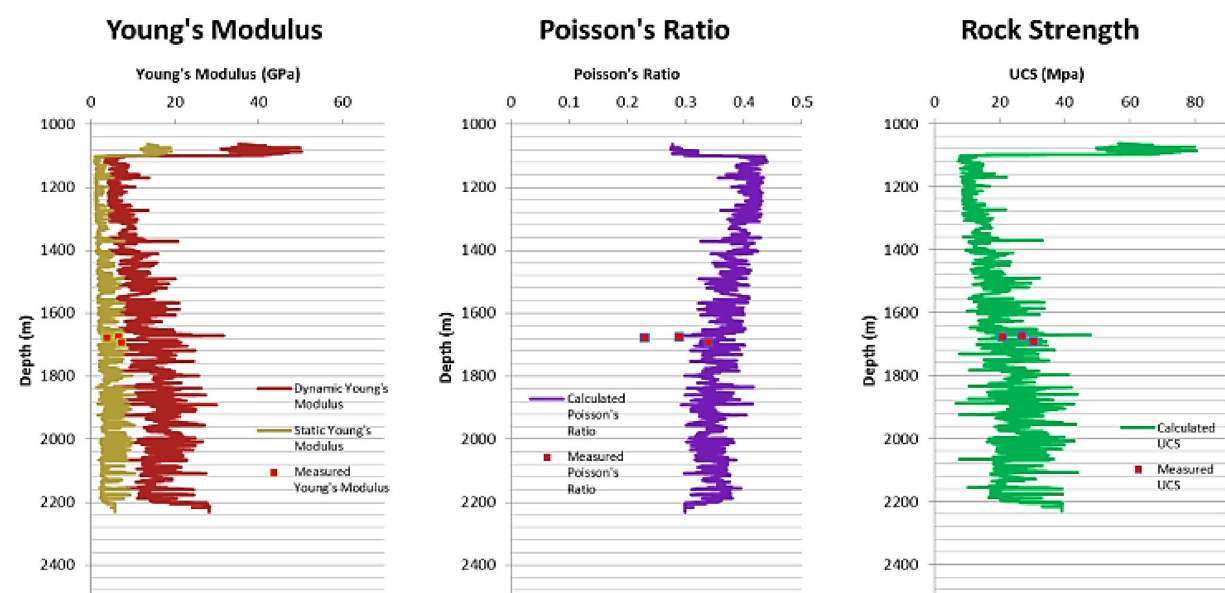
Fig. 1 Elastic constants and rock strength along the depth of Well X